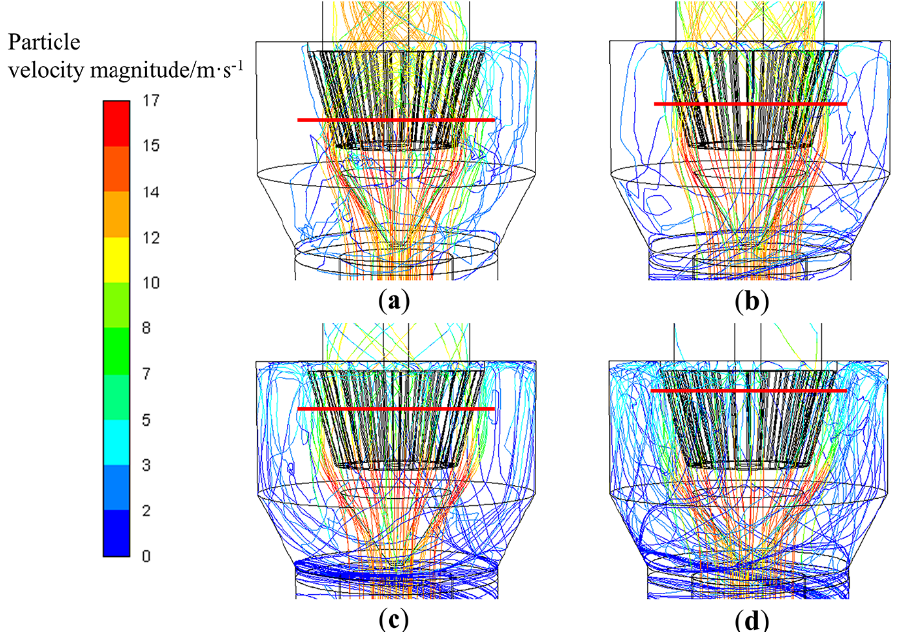
Figure 11. Trajectories of different size particles in T-D (1-0.7) : ( a ) d = 5 μ m, ( b ) d = 15 μ m, ( c ) d = 25 μ m, and ( d ) d = 35 μ m.